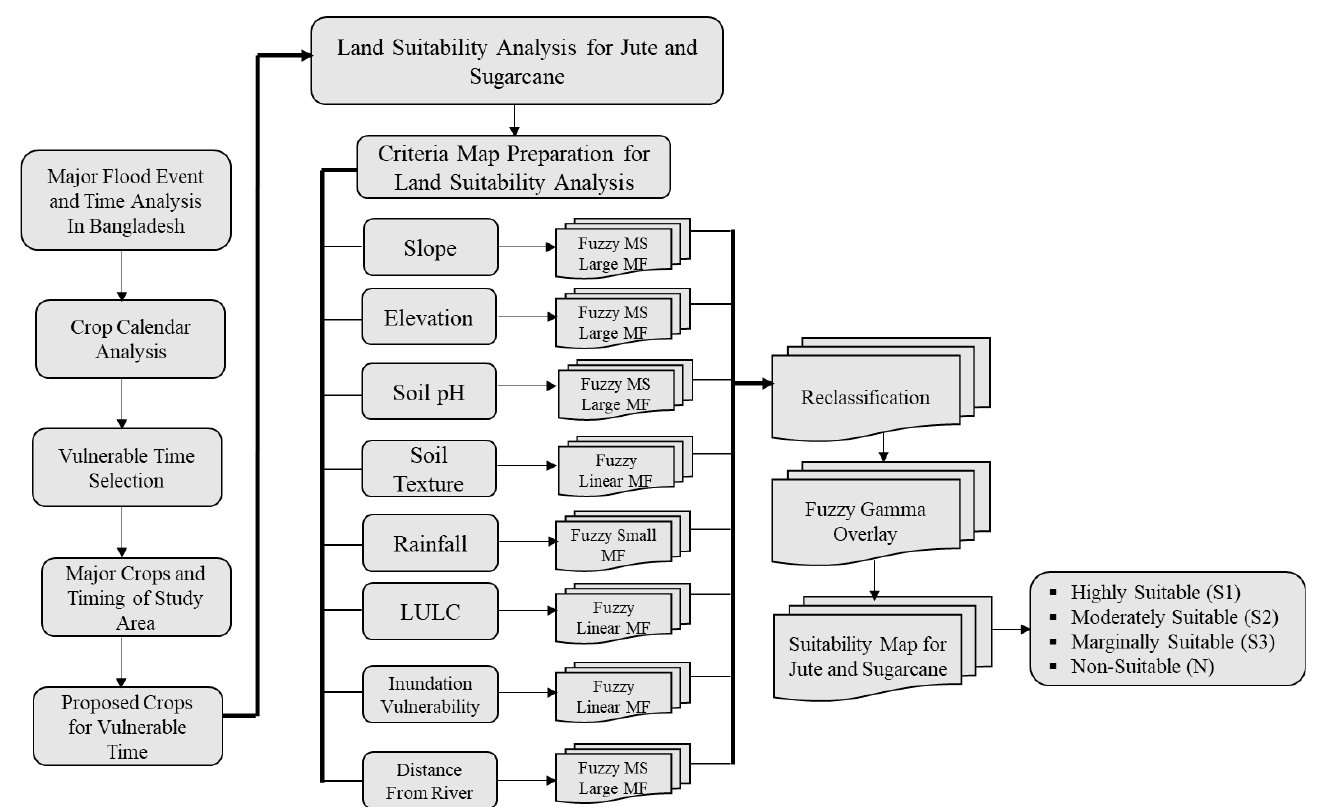
Figure 2. Stepwise workflow for inundation vulnerability assessment in the riverine area.